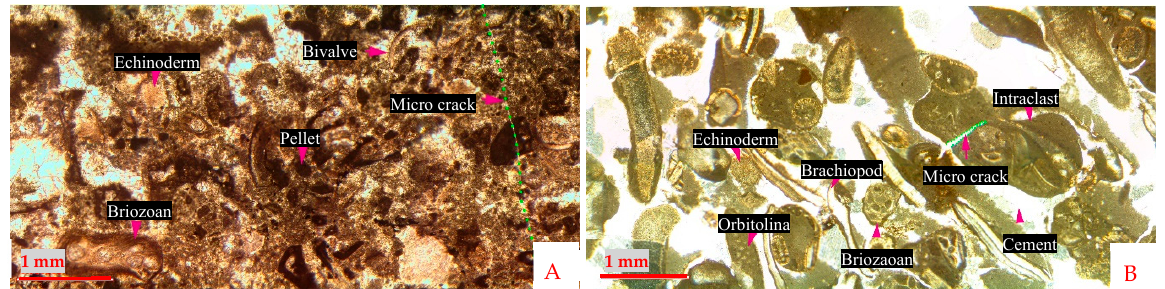
Figure 8. Thin section photomicrographs of some of the studied samples: R20 ( A ) and R14 ( B ).